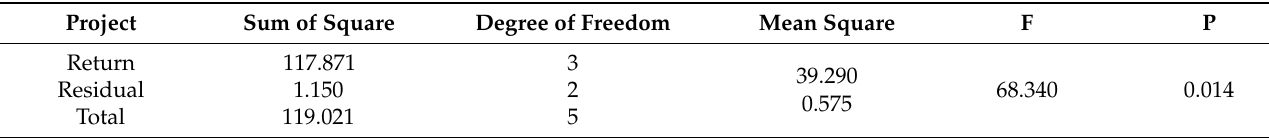
Table 2. Analysis of variance.